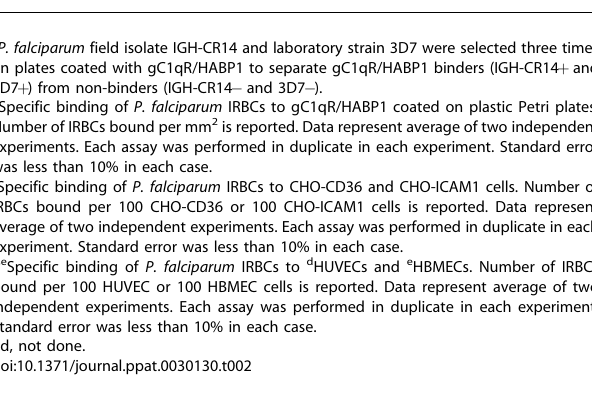
a P. falciparum field isolate IGH-CR14 and laboratory strain 3D7 were selected three times on plates coated with gC1qR/HABP1 to separate gC1qR/HABP1 binders (IGH-CR14 þ and 3D7 þ ) from non-binders (IGH-CR14 (cid:2) and 3D7 (cid:2) ). b Specific binding of P. falciparum IRBCs to gC1qR/HABP1 coated on plastic Petri